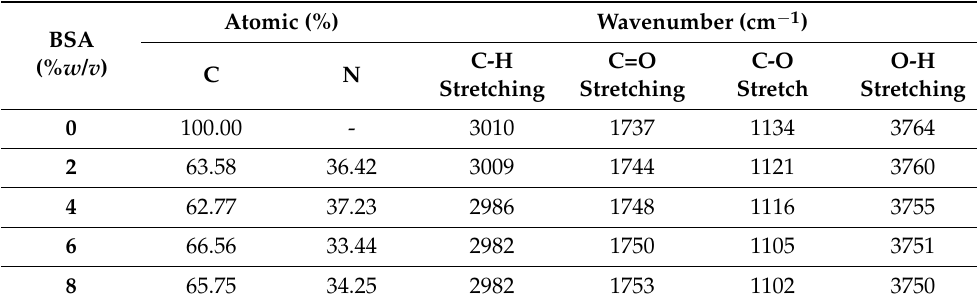
Table 1. EDXRF elemental analysis and data vibrational assignments of the PLG microparticles with various concentrations of BSA